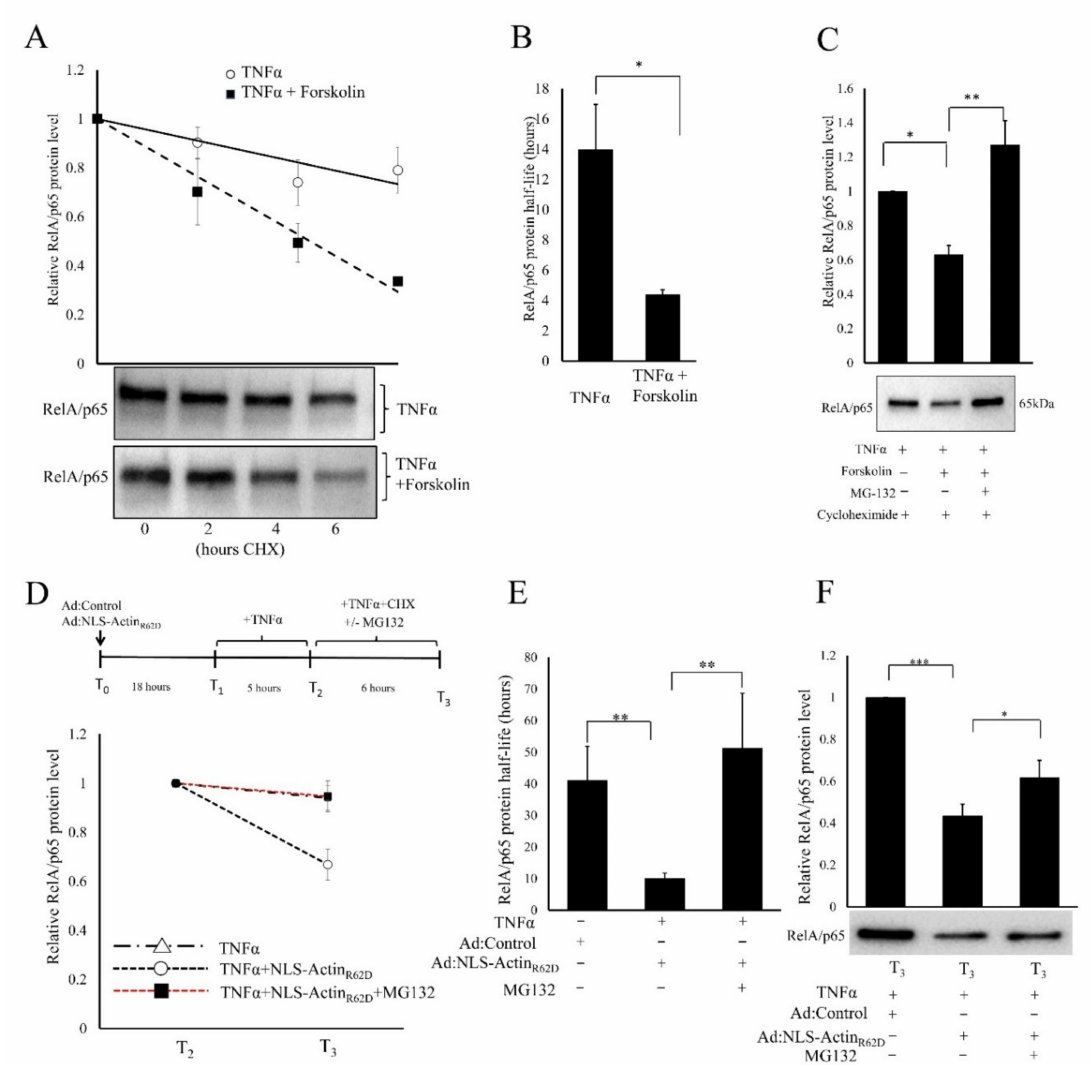
Figure 8. Cyclic-AMP and nuclear actin monomers induce RelA/p65 proteasomal degradation. Serum-starved VSMCs were stimulated with TNF α and forskolin for 5 h, as indicated. Following this, cells were incubated with cycloheximide for the indicated times. Total cell lysates were analysed for RelA/p65 protein levels by Western blotting and densitometry analysis (( A ); n = 5). The RelA/p65 protein half-life was calculated (( B ); n = 5). Serum-starved VSMCs were stimulated with TNF α and forskolin for 5 h, as indicated. Following this, cells were further treated with cycloheximide and MG-132 for a further 6 h. Total cell lysates were analysed for RelA/p65 protein levels by Western blotting and densitometry analysis (( C ); n = 4). VSMCs were infected with either Ad:Control or Ad:NLS-Actin R62D and stimulated with TNF α for 5 h before incubation with cycloheximide and MG132, as indicated. Total cell lysates were analysed for RelA/p65 protein levels by Western blotting and densitometry analysis, before calculating the degradation rate and half-life of RelA/p65 protein (( D – F ); n = 5). ANOVA with Student Newman Keul’s post hoc test. Data are mean ± SEM. *, ** and *** indicate p < 0.05, 0.01 and 0.001,